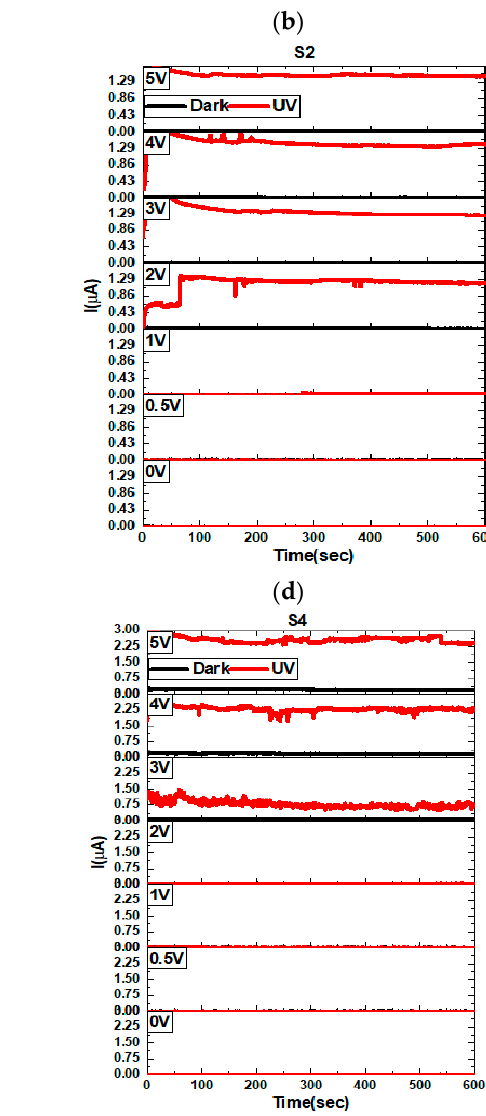
Figure 14. The photodetector performance with time at different applied voltage biases of 0, 0.5, 1, 2, 3, 4, and 5 V for S1 ( a ), S2 ( b ), S3 ( c ), and S4 ( d ) samples. Where ( a – d ) are deposited at 100, 150, 200, and 250 °C, respectively. All these samples were deposited via 100 pulse conditions.